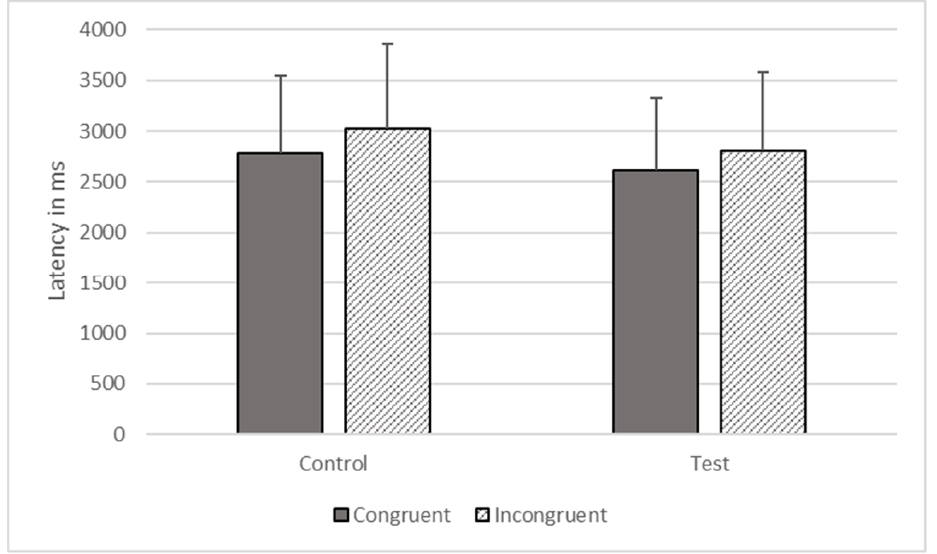
Figure 7. Response latencies as a function of trial types in Phase Five.